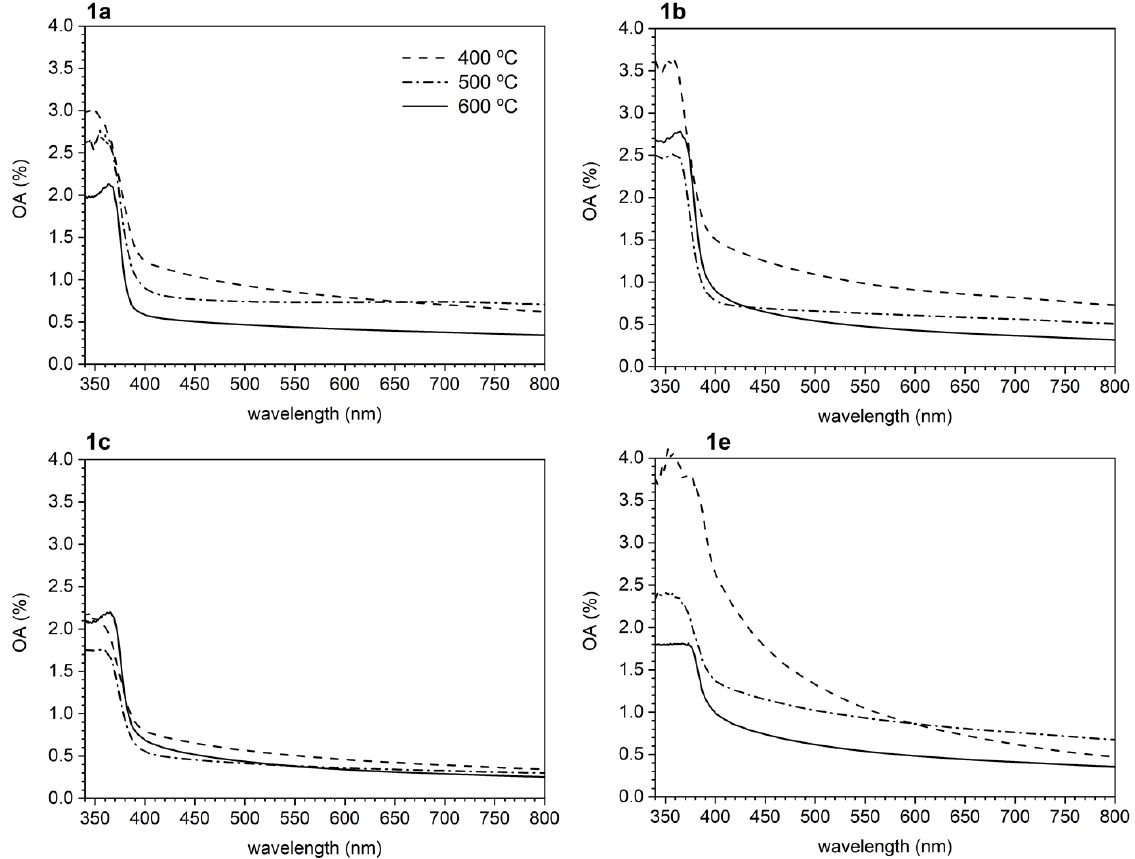
Figure 7. UV-VIS absorption spectra of films 1a–1c and 1e at every annealing temperature.